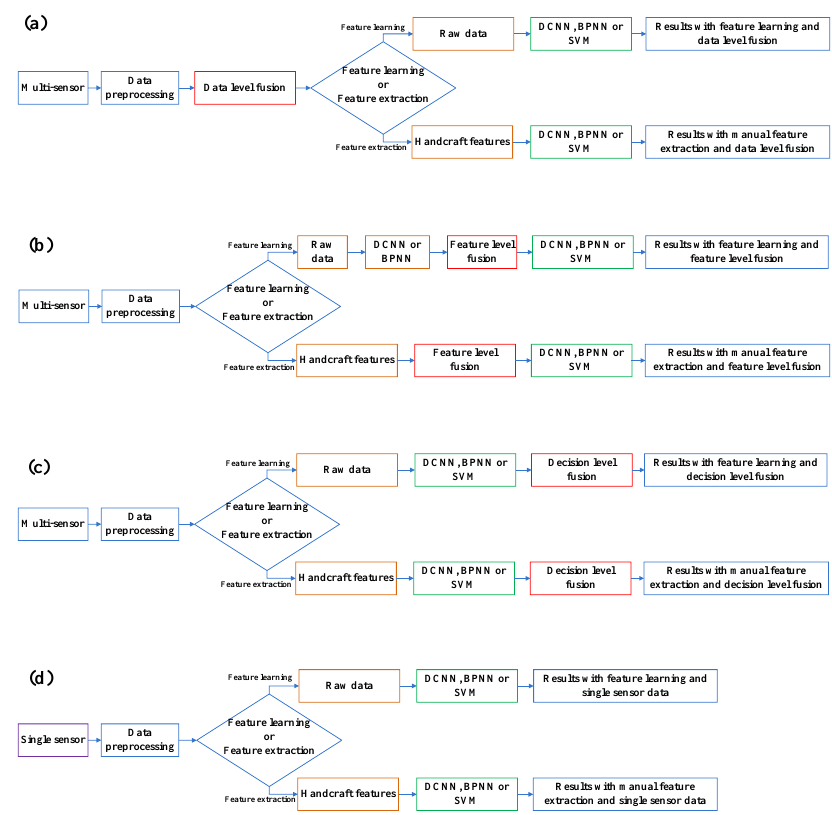
Figure 3. Flowcharts of comparative methods: ( a ) Data-level fusion methods; ( b ) Feature-level fusion methods; ( c ) Decision-level fusion methods; and ( d ) Methods with single sensory data.